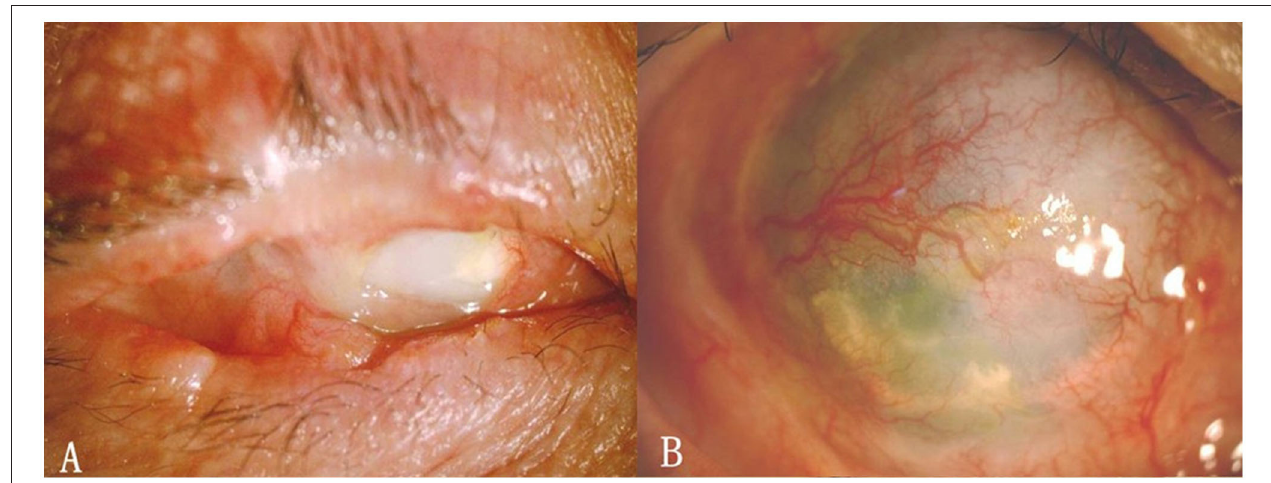
FIGURE 1 | (A) Extensive symblepharon with conjunctival sac atresia. (B) Symblepharon was completely released 9 months after allogeneic CLET (A and B are from the same patient).